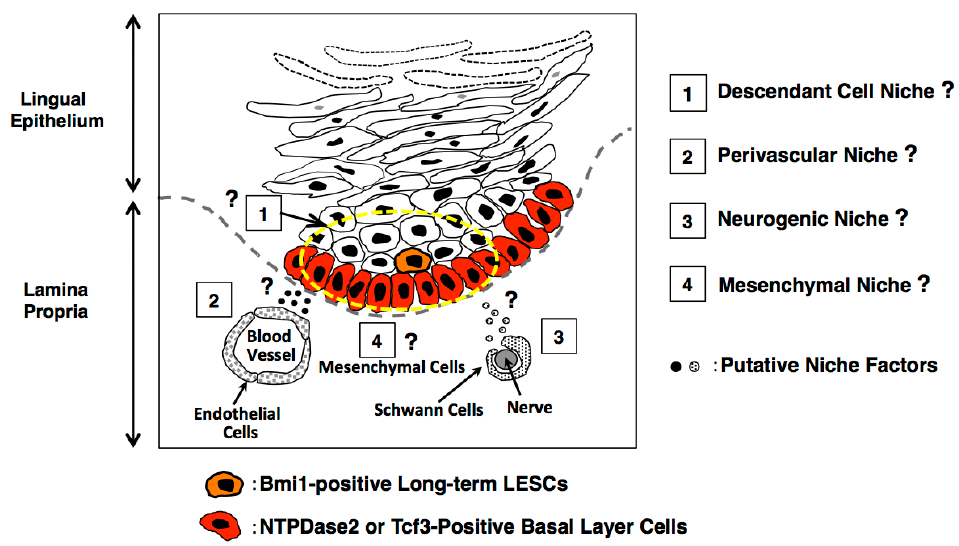
Figure 4. Putative lingual stem cell niche deduced from other stem cell systems.